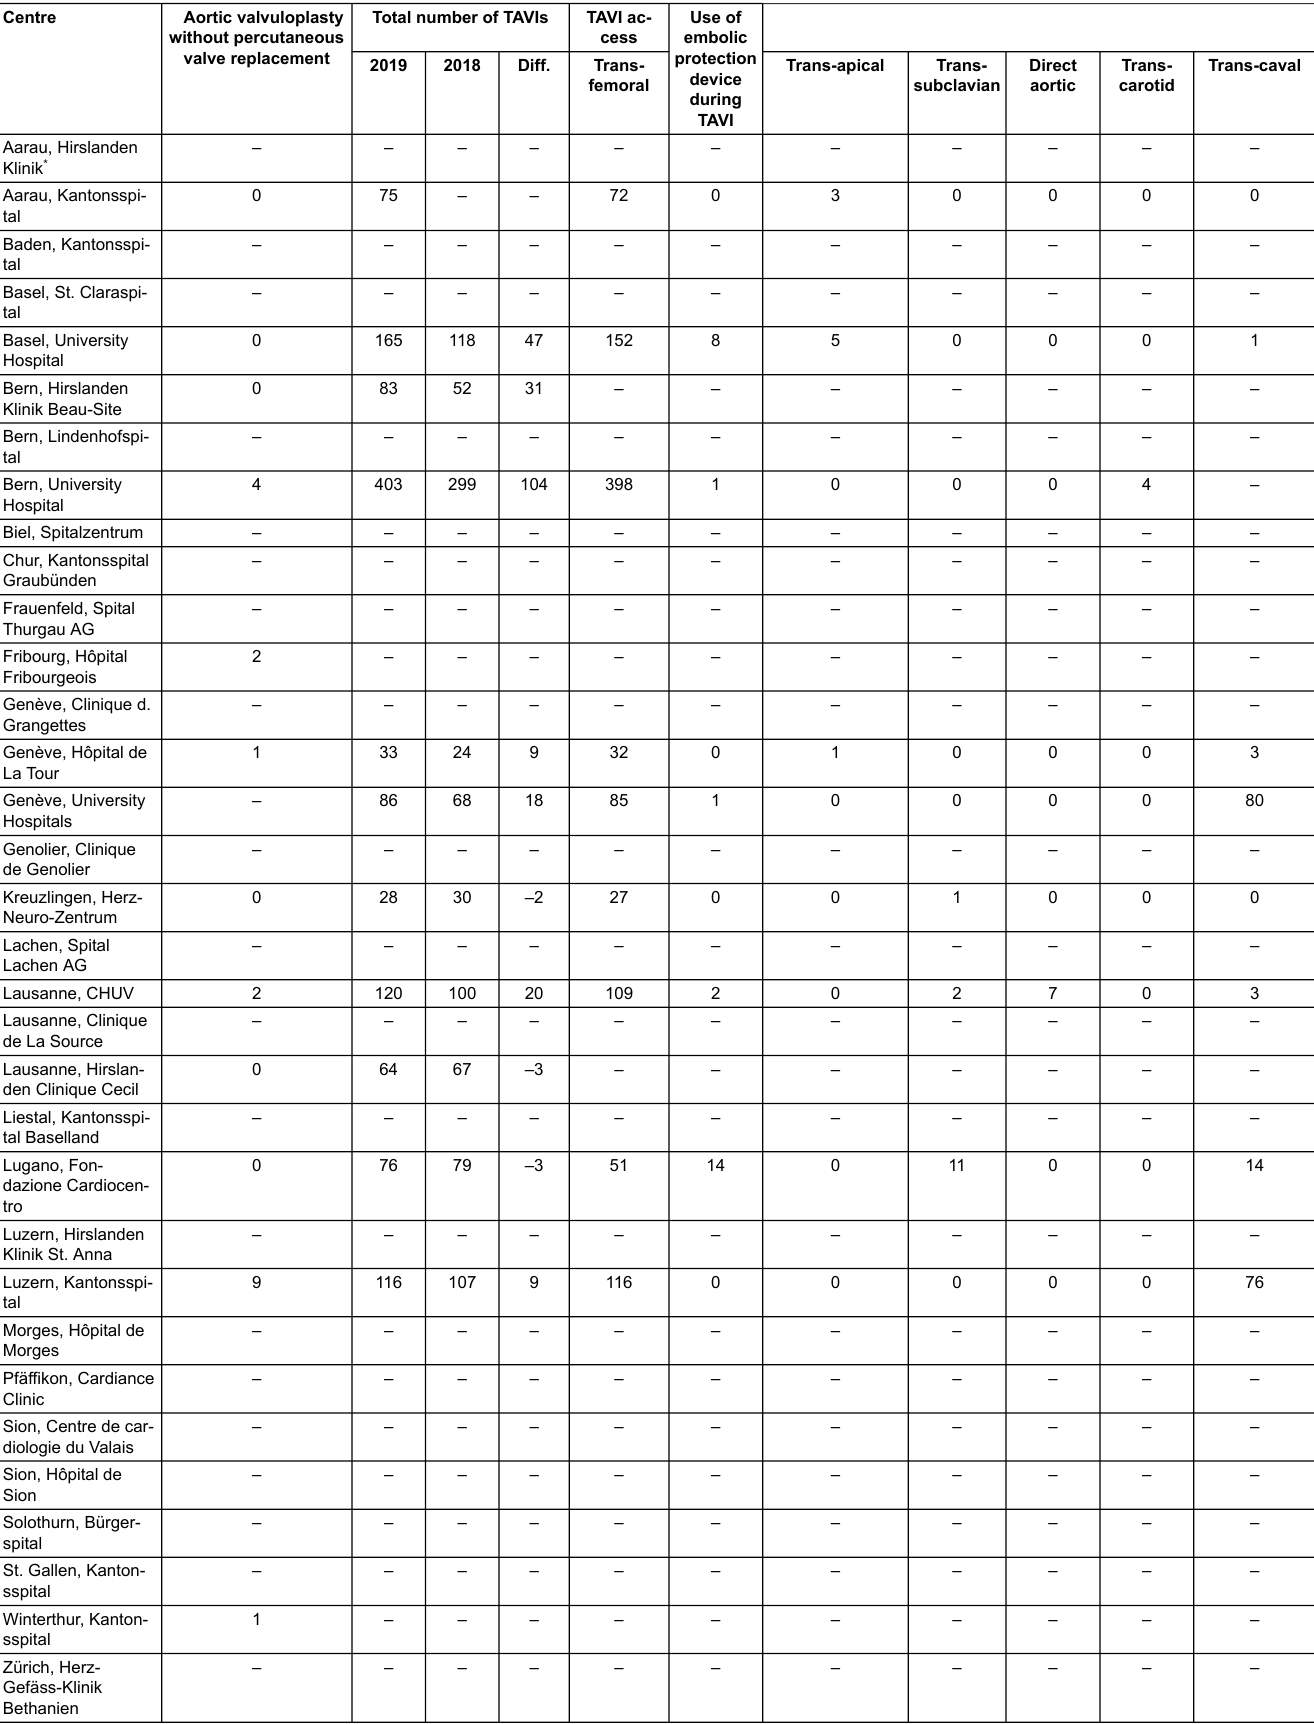
Table 6: Transcatheter aortic valve implantations in Switzerland 2019. Centre Aortic valvuloplasty without percutaneous